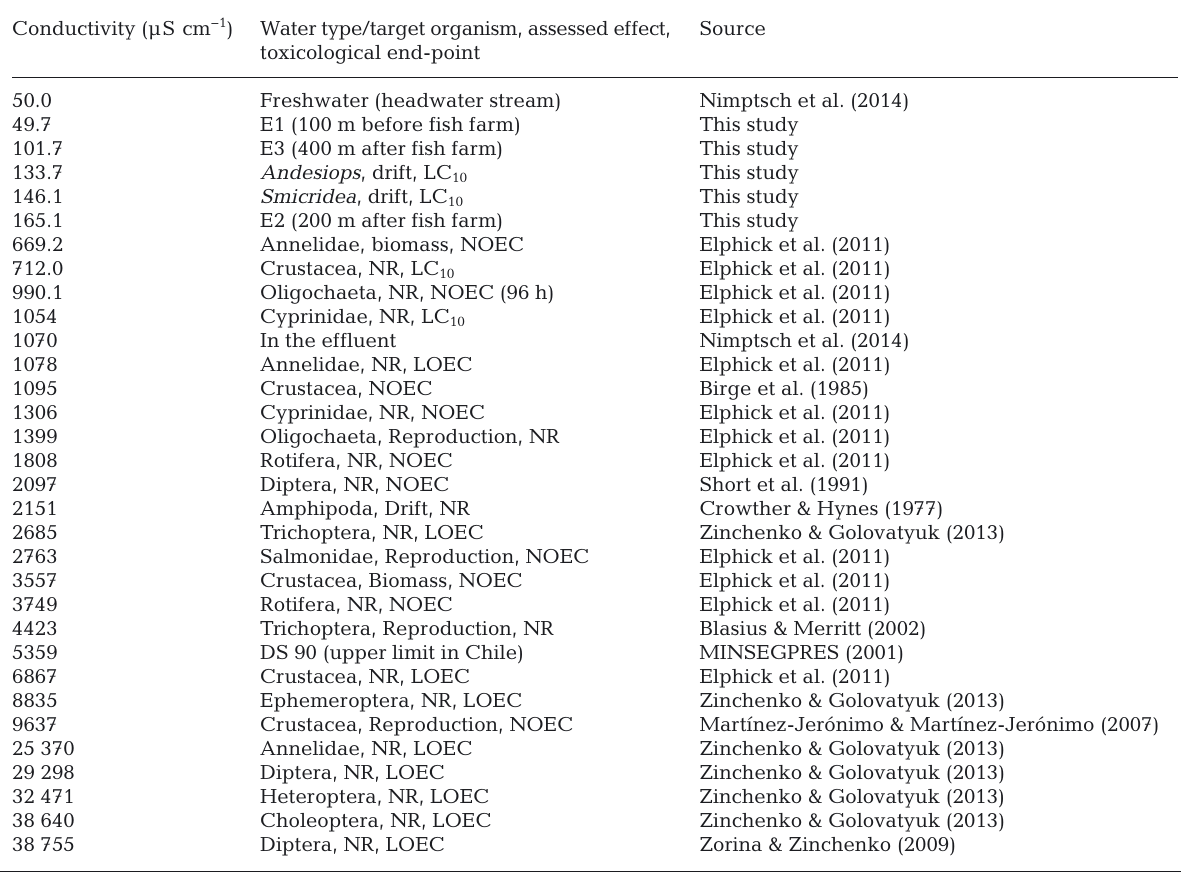
Table 3. Chronic ecotoxilogical endpoint values of freshwater benthic organisms compared to water quality reference values, fish farm effluents and Chilean environmental quality values measured as specific conductivity in water. LC 10 : salt concentration at which 10% of individuals die; NR: not registered; NOEC: non-effect conductivity; LOEC: lowest-effect conductivity Conductivity (µS cm −1 ) Water type/target organism, assessed effect, Source toxicological end-point 50.0